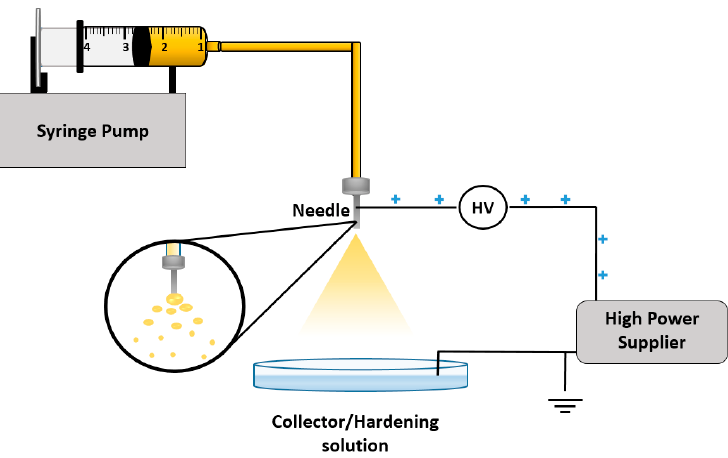
Figure 7. Schematic representation of electrospray technique.